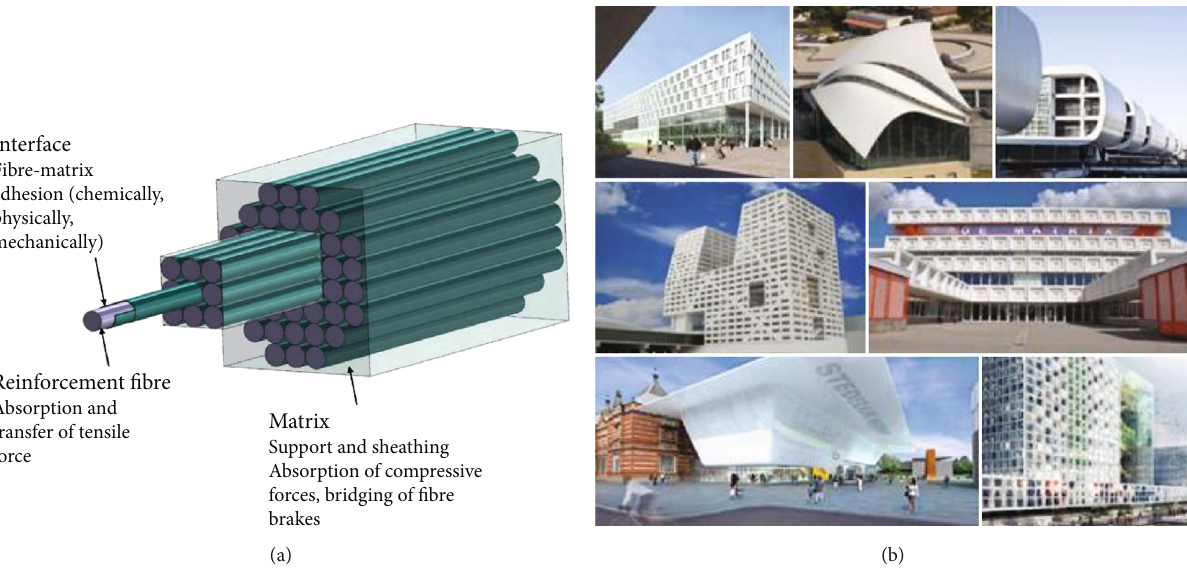
Figure 2: Typical structure of FRPs (a) and examples of FRP building facades (b)